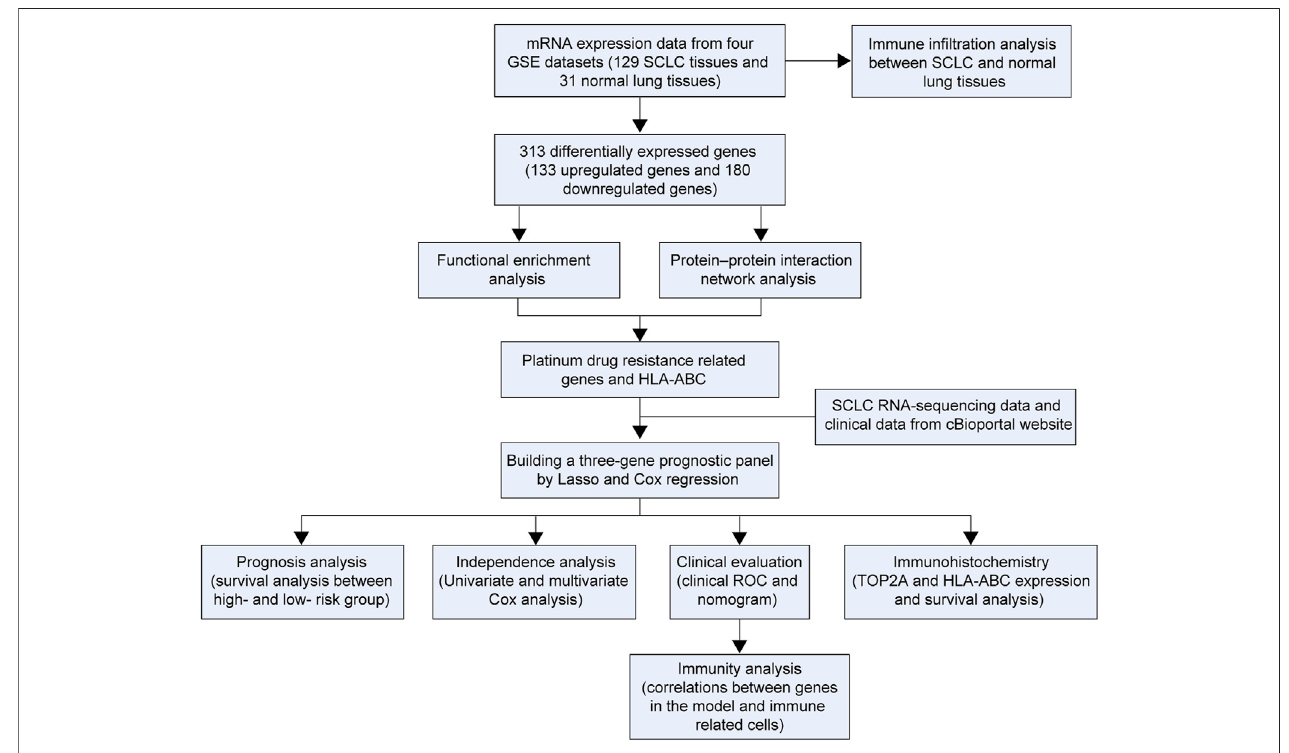
FIGURE 1 | Flowchart of the study.